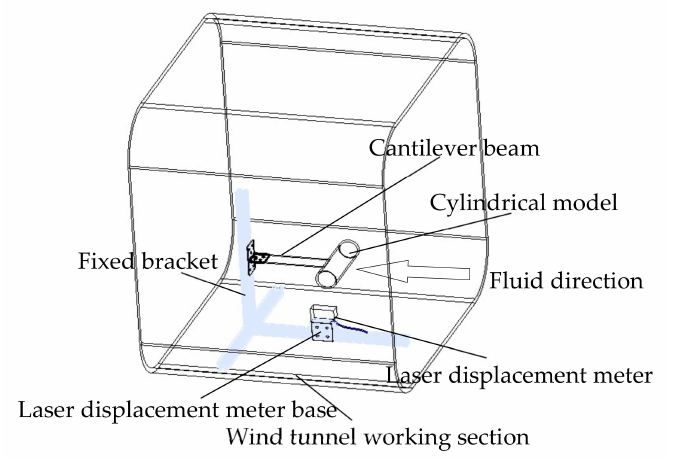
Figure 3. Diagram of experimental model and sensor. Table 1. Parameters of cylindrical